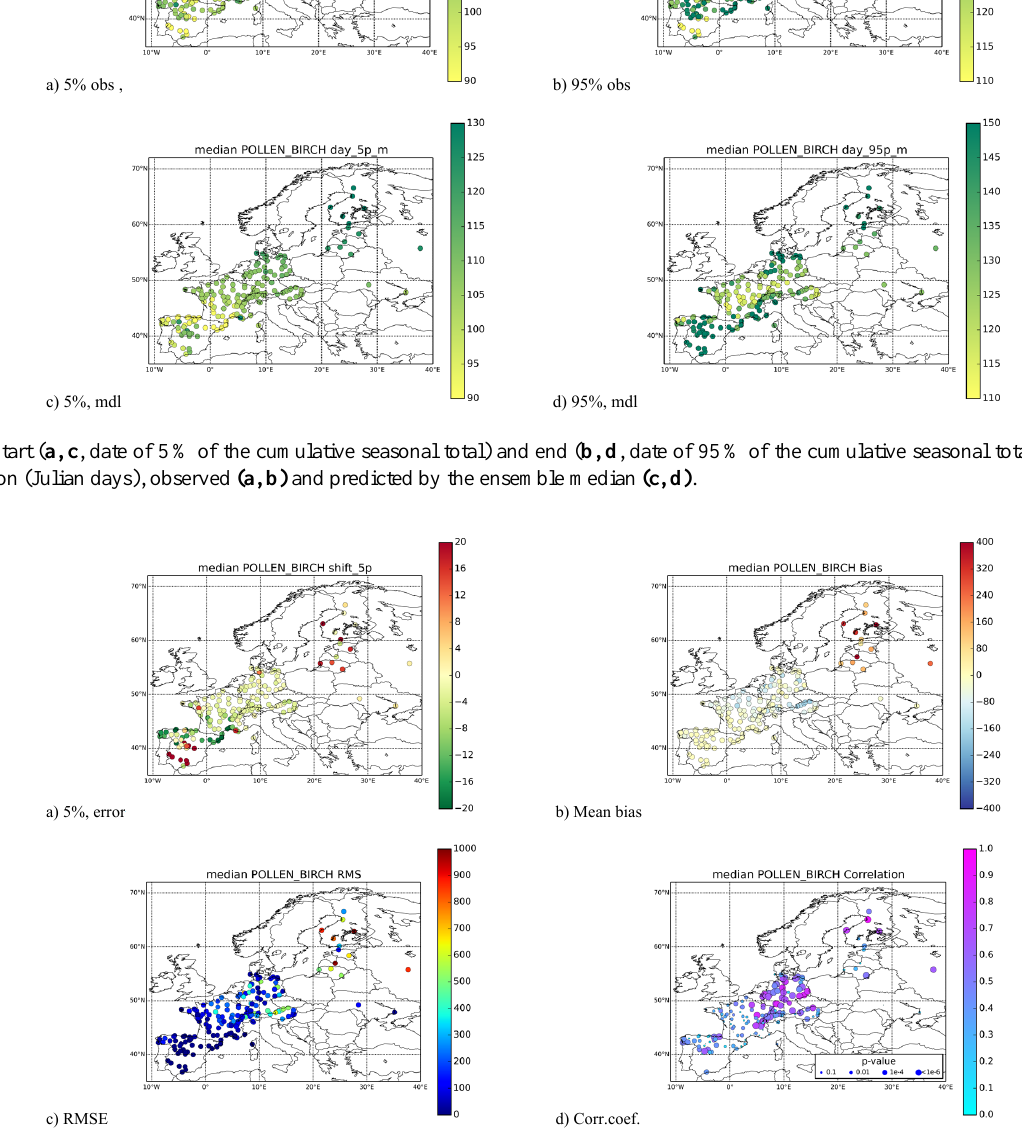
Figure 7. Results of model–measurement comparison for the ensemble median: error in the season start ( a , days), seasonal mean bias ( b , pollenm − 3 ), RMSE ( c , pollenm − 3 ), correlation coefficient for daily time series (d)